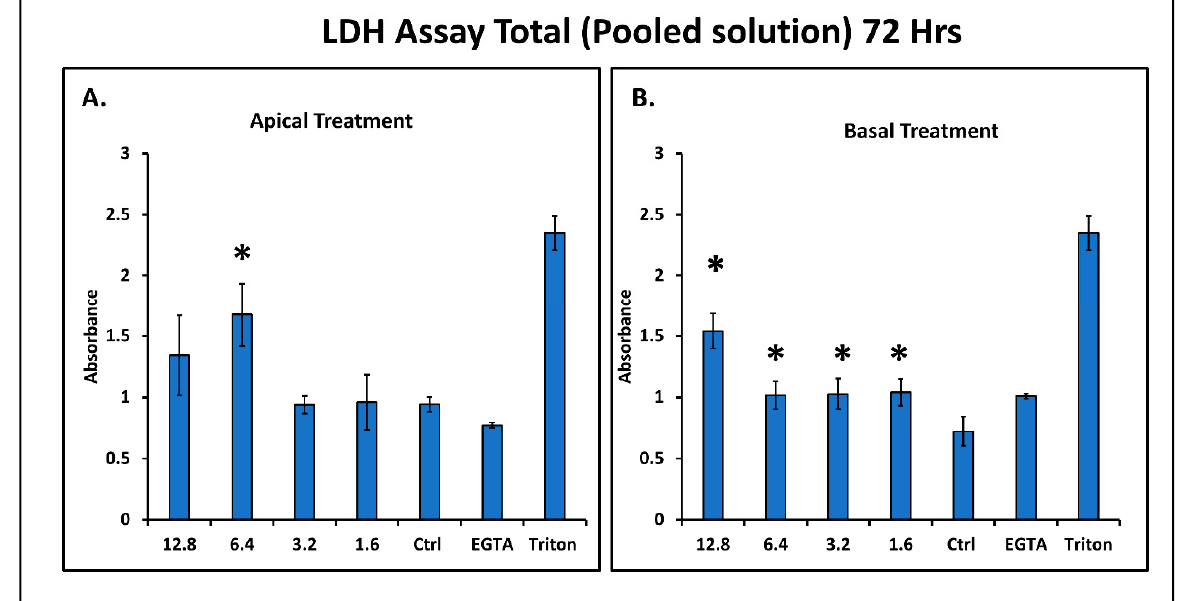
Figure 4. Effect of the exposure of sodium arsenite on release of LDH. LDH release was measured in the cell culture supernatant collected from the apical ( A ) or basal ( B ) compartment after 72 h treatment from respective sides with the sodium arsenite concentrations 1.6, 3.2, 6.4 and 12.8 µM or 2 mM of EGTA (as positive control). Triton was used as a positive control for cell lysis. Absorbance was measured at 450 nm at the endpoint. (* p < 0.05).